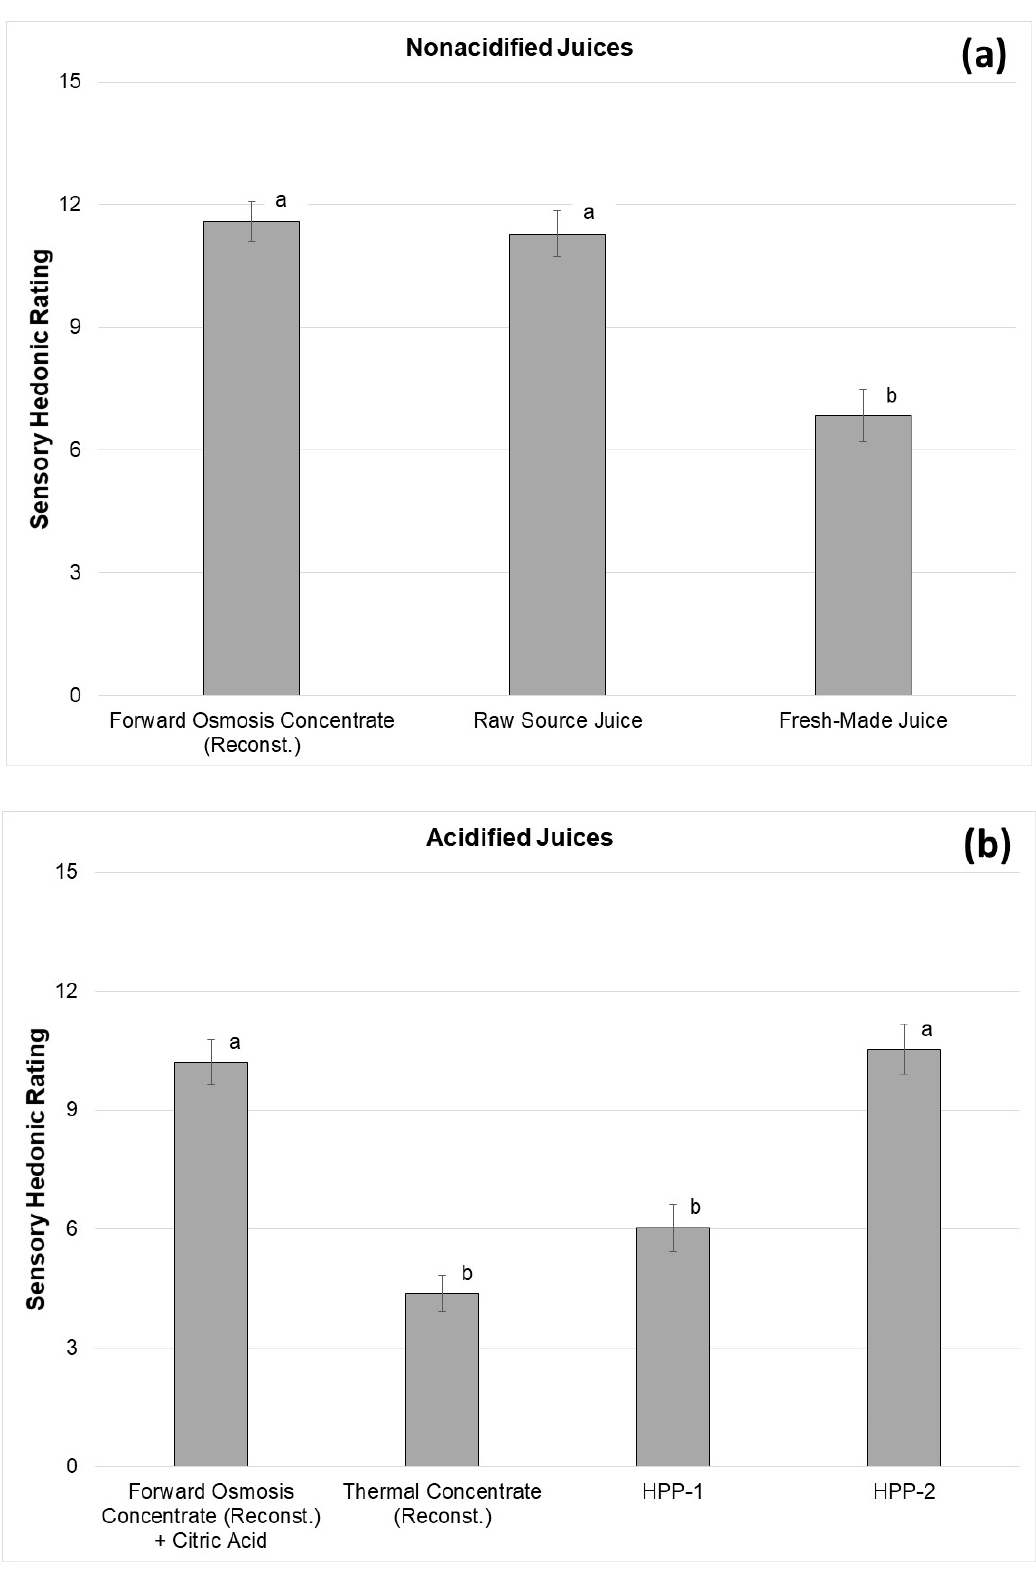
Figure 3. Sensory hedonic (liking) scores for watermelon juices without any acid added ( a ) and with acid added ( b ). Higher scores indicate better liking. Error bars indicate ± 1 standard error of the mean.